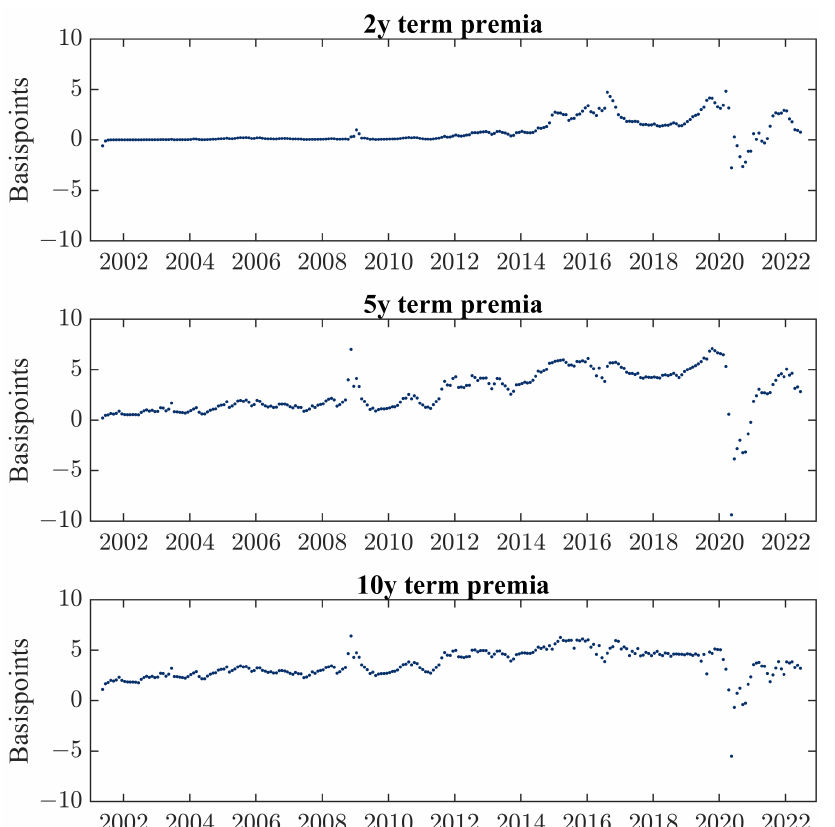
Figure 4. Impact on term premia estimates from ZLB. Comparison of term premia estimates from BR and JSZ. Negative numbers imply higher term premia estimates from BR relative to JSZ. Sample period: 2001/04 to 2022/06.